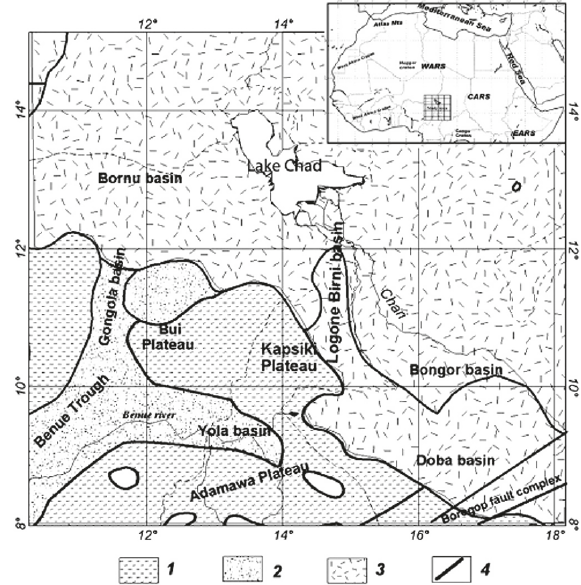
Figure 2: Geological map of the study area: (1) Precambrian; (2) Early Cretaceous; (3) Tertiary-Quaternary; and (4) faults or major structural elements (modified from Eyike et al.,